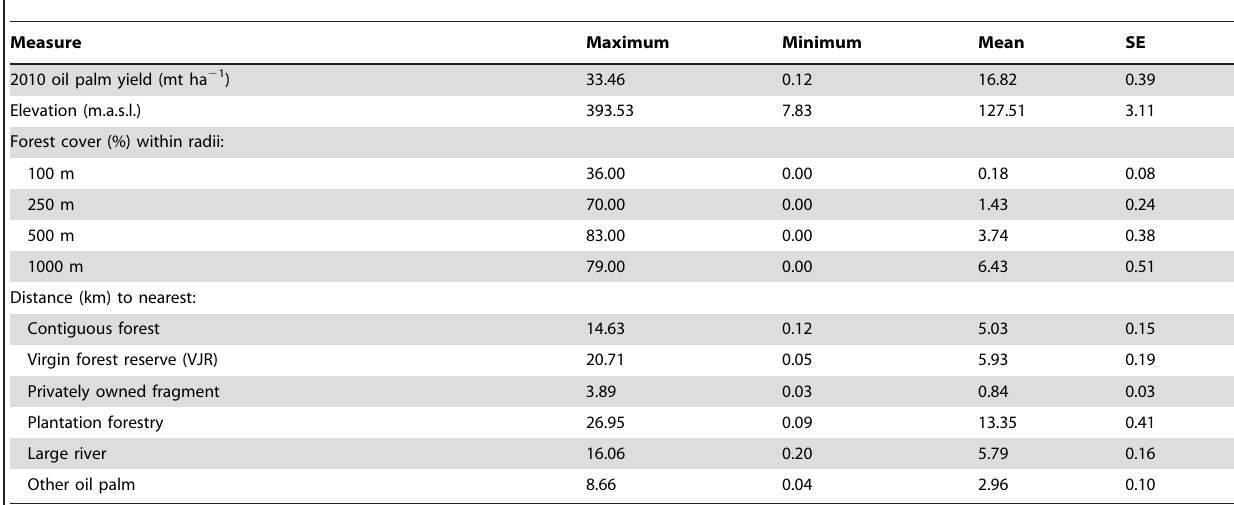
Table 1. The range and mean ( 6 SE) of oil palm yield, elevation, and nearest distance to different forest classes, forestry plantations, large rivers and other (not within Sabah Softwoods Bhd.) oil palm plantations within 499 oil palm coupes in Sabah, Malaysian